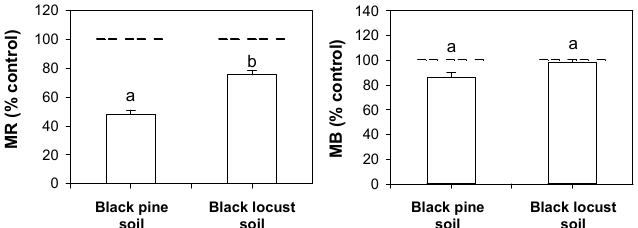
Figure 4. Changes in mineralization rate (MR) and microbial biomass (MB) after amendment of black pine and black locust mineral soil with water extracts of black locust forest ‐ floor litter. Changes are presented as percent of MR and MB in non ‐ amended (control: dashed line) soil (0–5 cm depth) and reported as the mean (±SE) from 20 samples. Different lowercase letters indicate statistically significant differences between the two soils ( t ‐ test, p < 0.05).